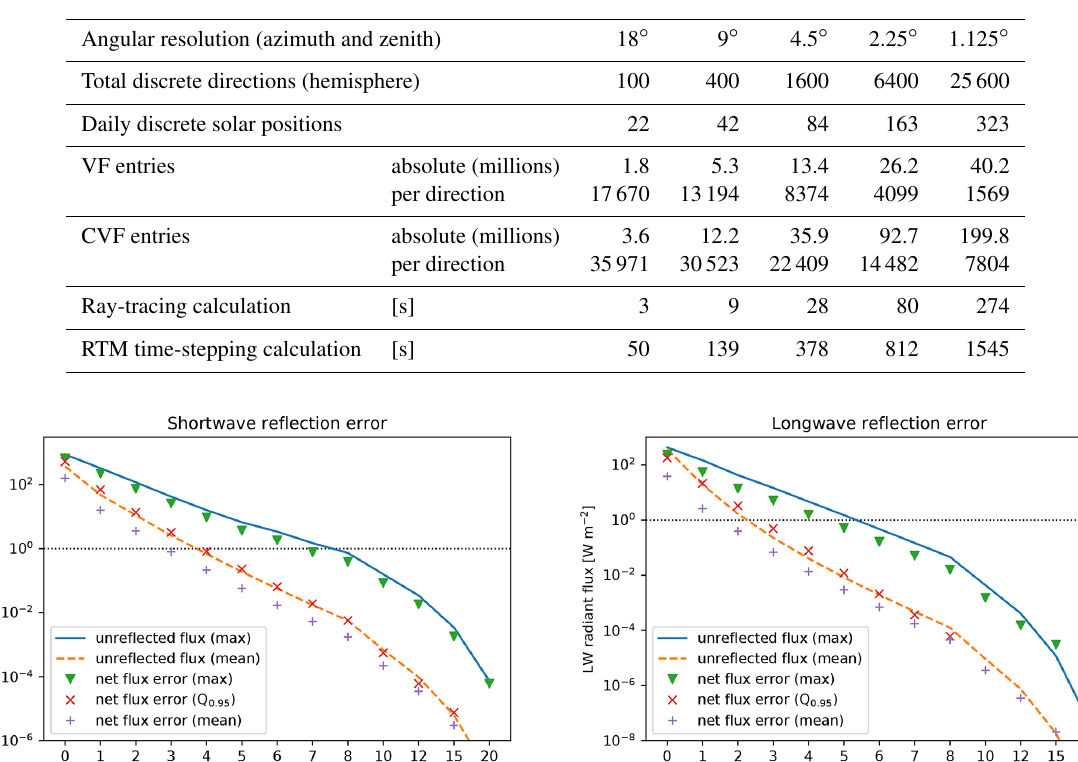
Table 1. Scaling of angular resolution.